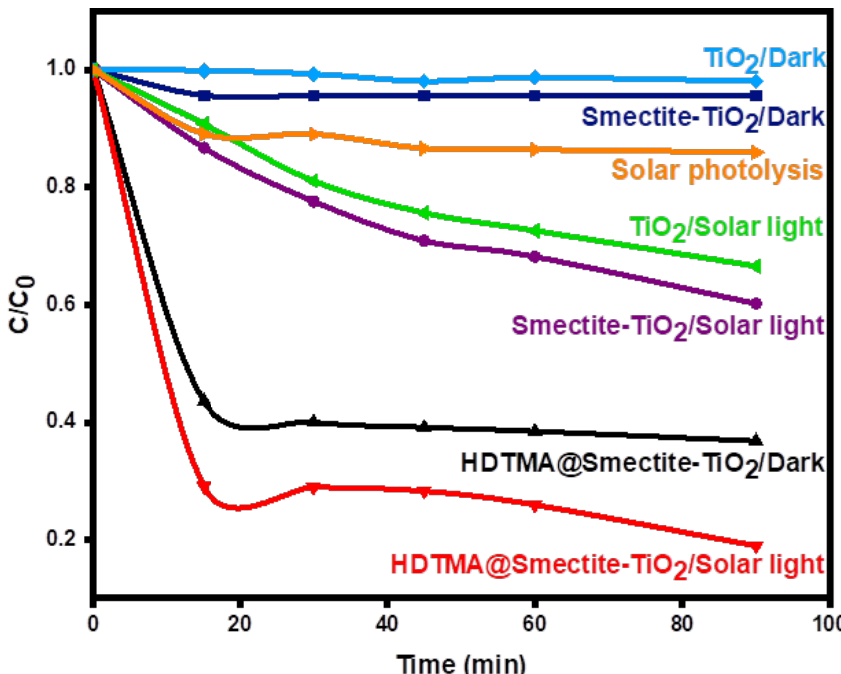
Figure 3. Adsorption, photolysis, and photocatalytic oxidation of diclofenac under solar irradiation by TiO 2 , Smectite-TiO 2 , and HDTMA@Smectite-TiO 2 . [Photocatalyst]: 0.5 g/L, [Diclofenac]: 100 ppm.